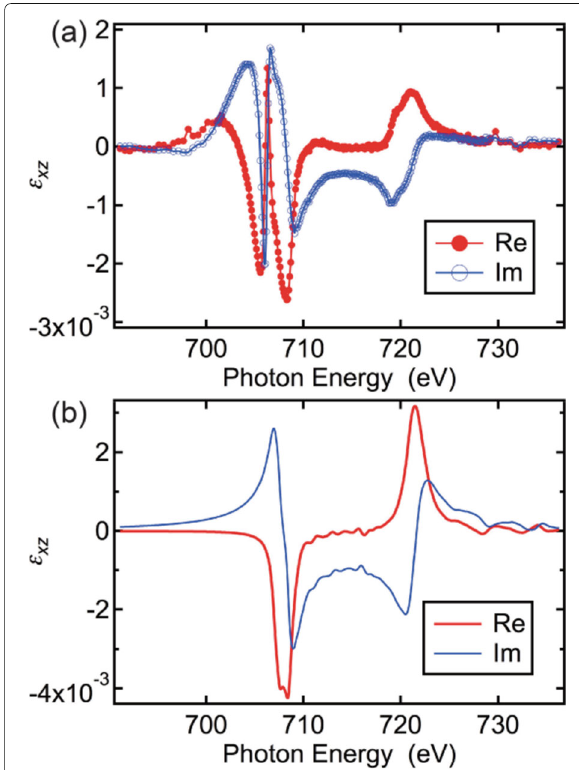
Fig. 26 Determination of the soft X-ray complex permittivity [32]. a Experimental spectra of the complex permittivity, ε xz , for the Fe nanofilm at the L -edge. Solid (red) and open (blue) circles represent the real and imaginary parts, respectively. b Calculated ε xz spectra of bulk Fe (bcc) at the L -edge by the first-principles calculation. Red and blue lines represent the real and imaginary parts, respectively 401.5 eV and 408.0 eV (Fig. 28(a)). From the matrix ele- ment in Equation 23, grazing (normal) incident light is supposed to promote electrons into the 2 p π ∗ ( σ ∗ ) orbital, which is pointing out-of-plane (lying in-plane). We hence assign the peak at 401.5 (408.0) eV to the transition into